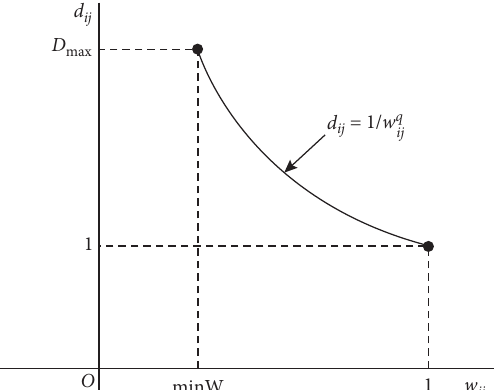
w ij of the relationship between nodes X i and X j . Here,